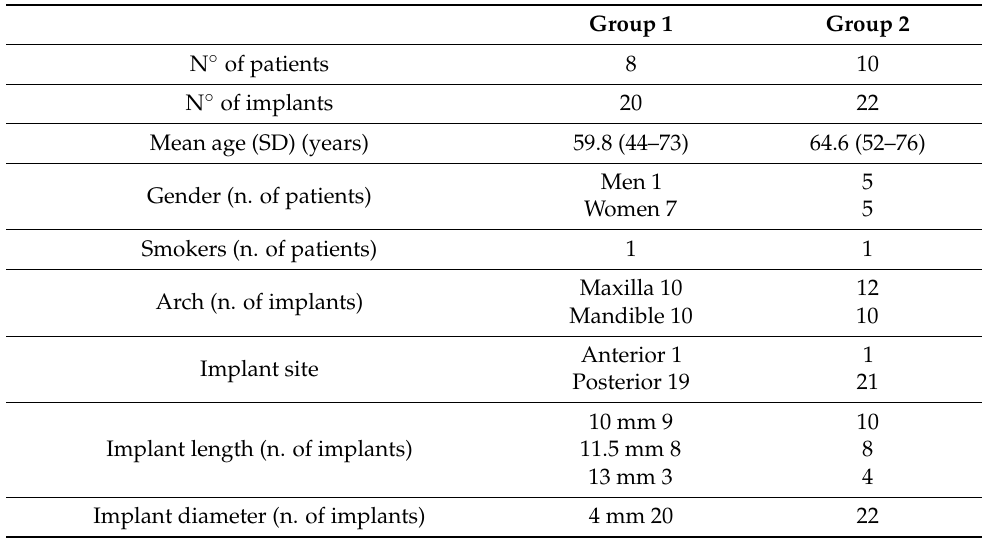
Table 1. Baseline characteristics of the two cohorts of